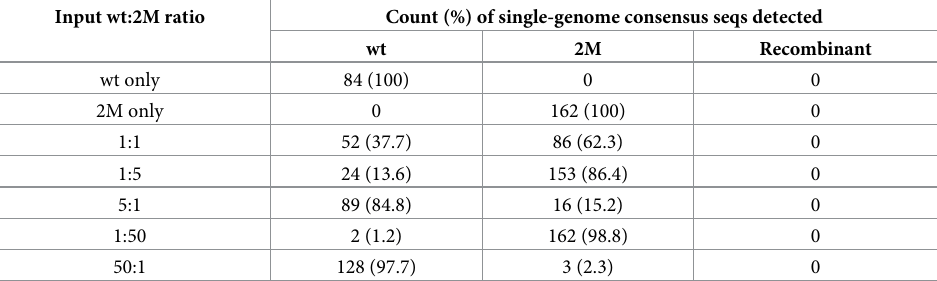
Table 1. Detection of input clonal sequences and recombinants in HT-SGS validation